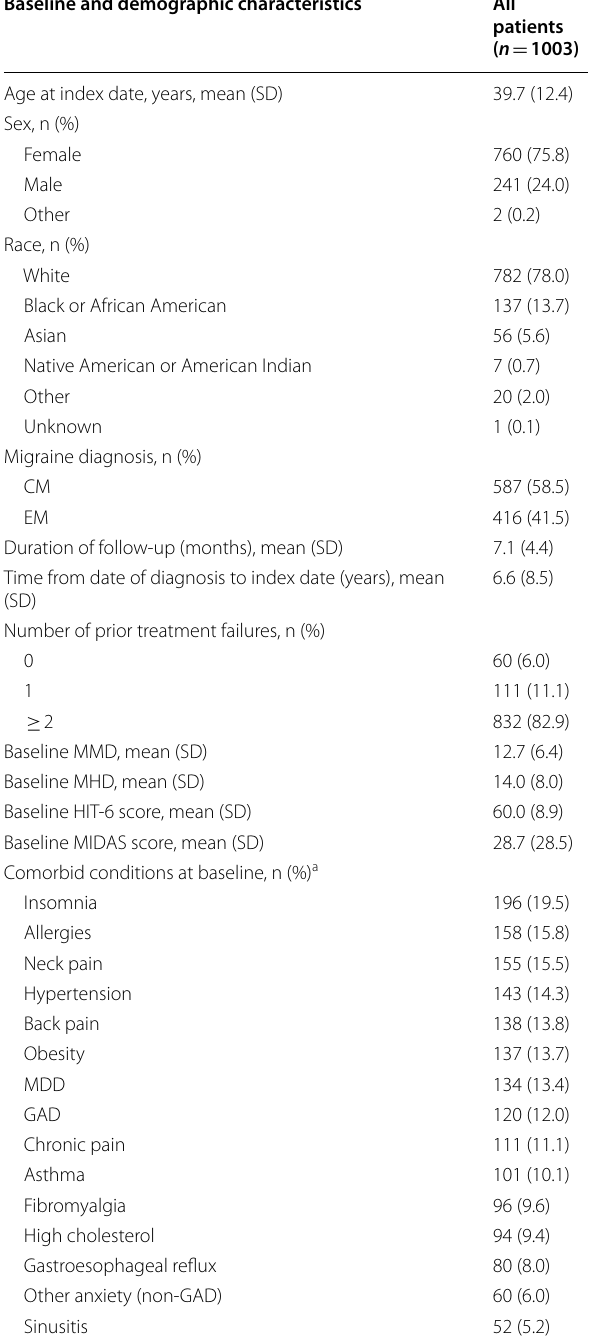
Table 1 Patient Baseline and Demographic